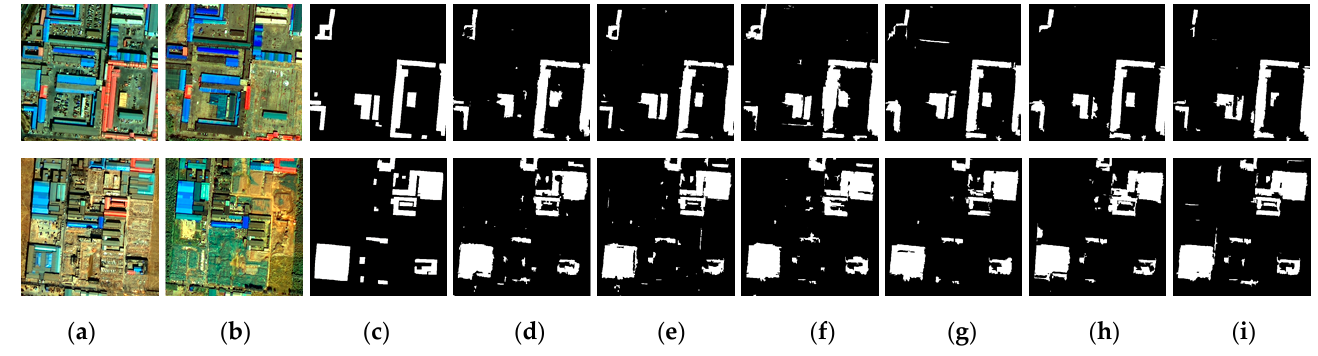
Figure 15. Two samples of CD results by DNHGNN with fixed S 1 = 8 and different S 2 . ( a ) Image T1. ( b ) Image T2. ( c ) Reference change map. ( d ) S 2 = 15. ( e ) S 2 = 18. ( f ) S 2 = 21. ( g ) S 2 = 24.